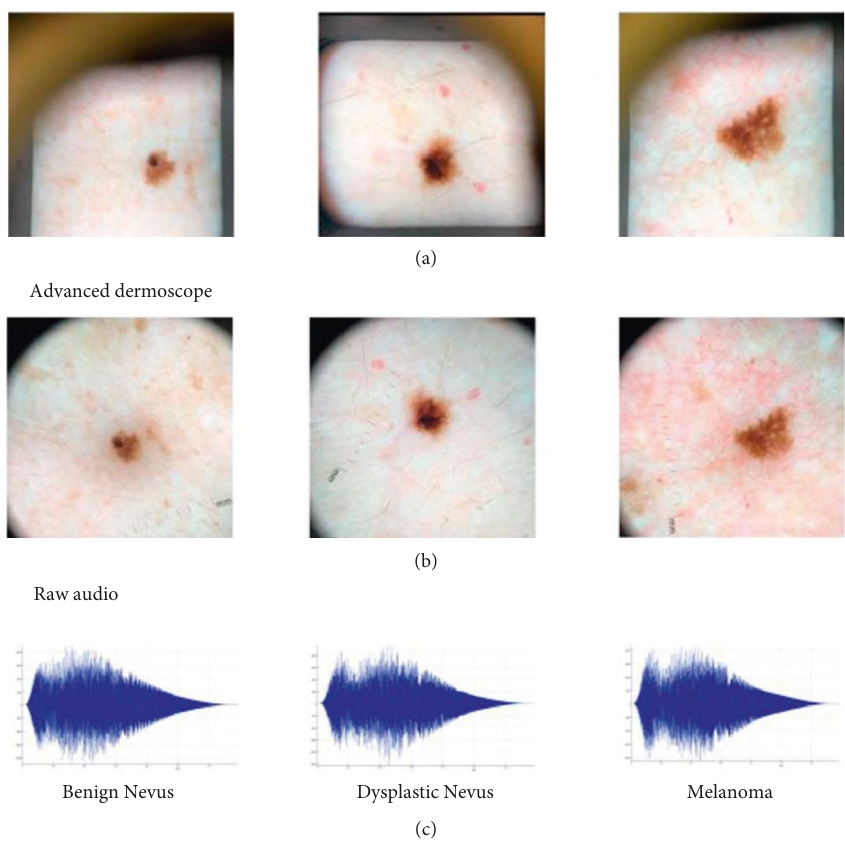
Figure 1: Detection of malignant lesions through skin magnifier using DL algorithm